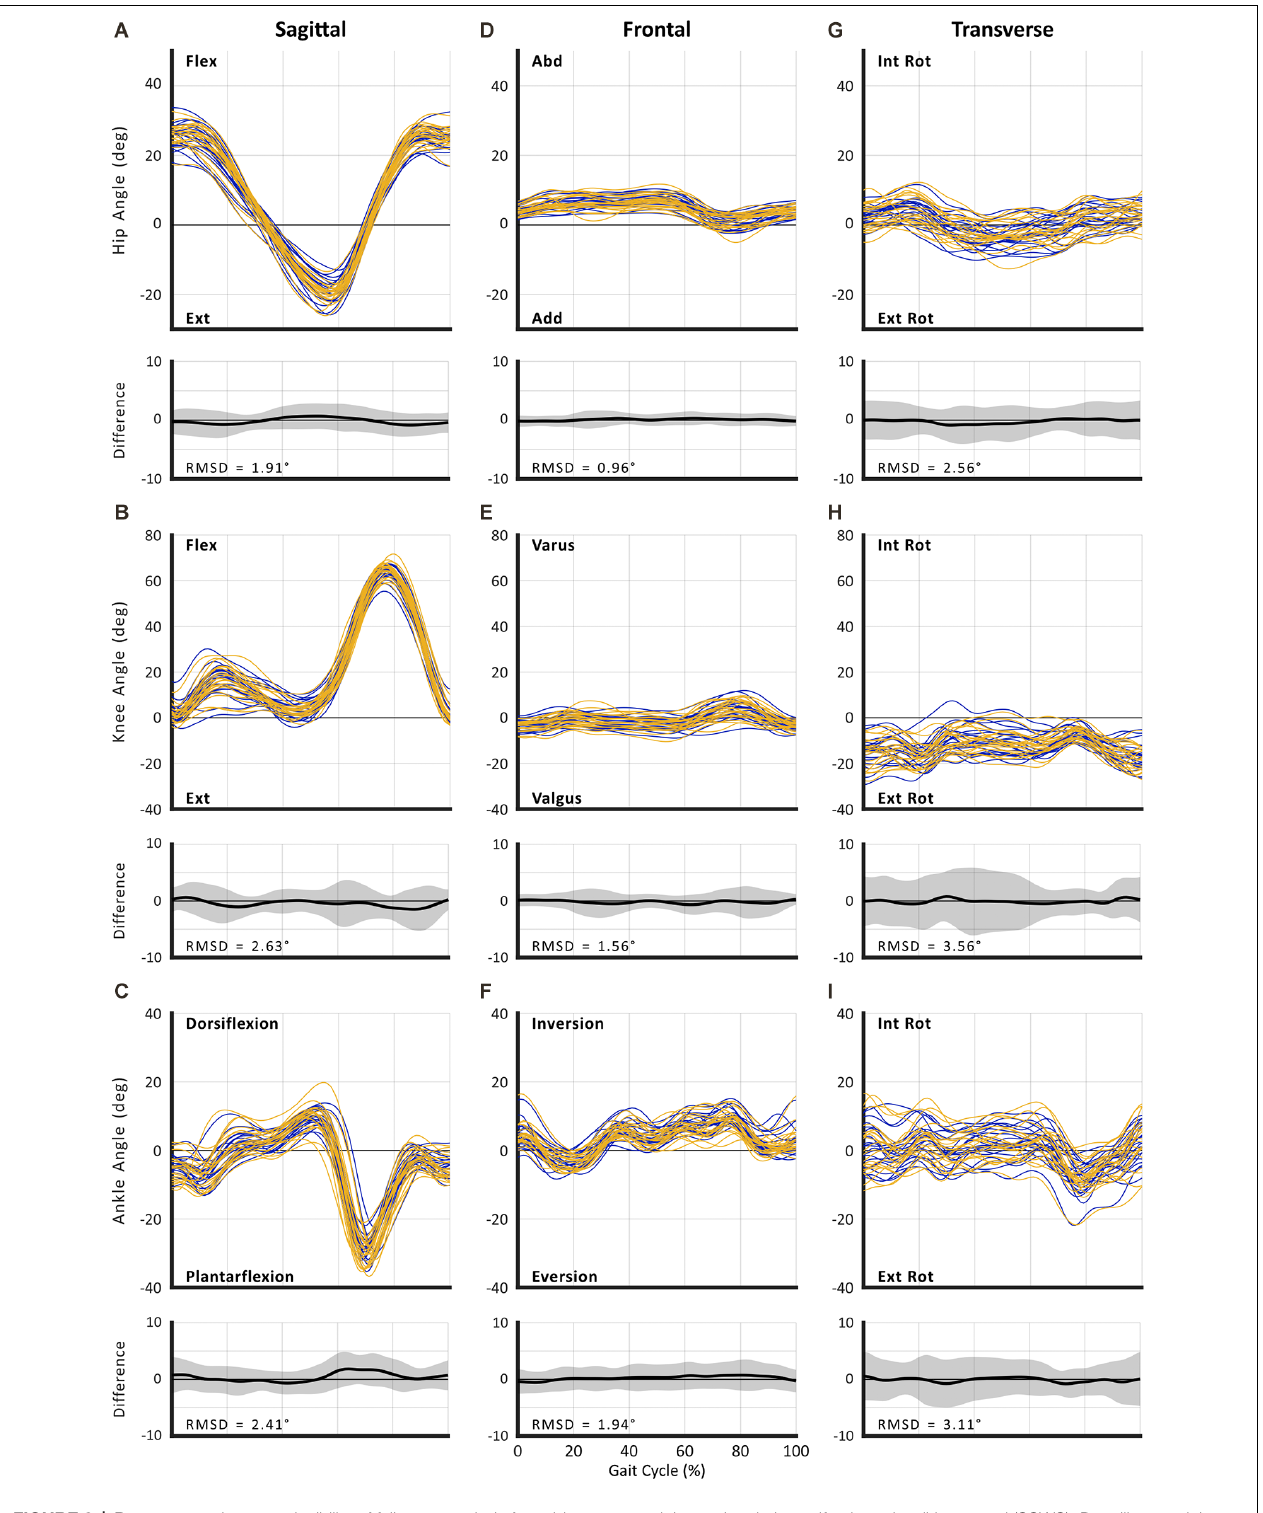
FIGURE 2 | Between-session reproducibility of full curve analysis for subject-average joint angles during self-selected walking speed (SSWS). Data illustrate joint angles for hip (row 1), knee (row 2), and ankle (row 3) in the sagittal (A–C) , frontal (D–F) , and transverse planes (G–I) . Each curve represents the ensemble average of each individual’s trials for Session 1 (blue lines) and Session 2 (gold lines). The average RMS difference across all subjects is shown below the respective joint angle plot; across all joints and planes of motion, the largest RMSD was 3.71 ◦ .